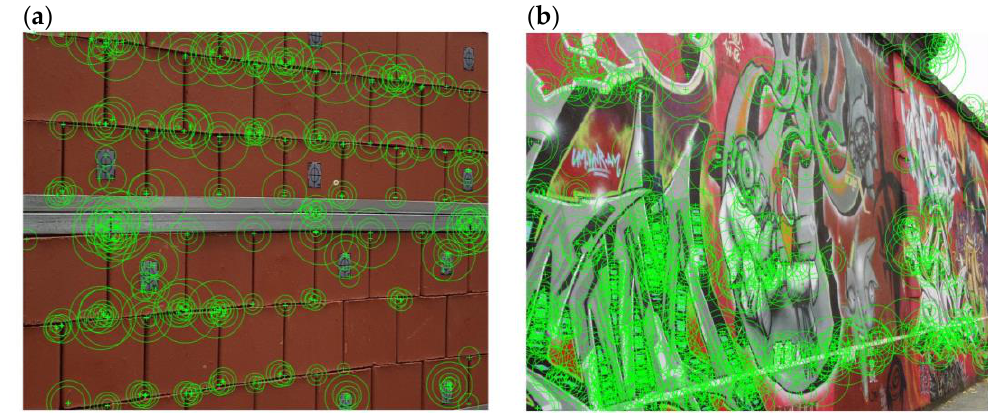
Figure 11. Detected features with different types of images. ( a ) Laboratory experiment; ( b ) Graffiti.